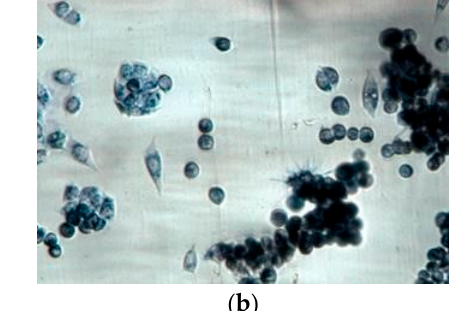
Figure 2. Modified commercial multifunctional platform for Gut-On-Chip Caco-2 cultures with embedded ITO electrodes.